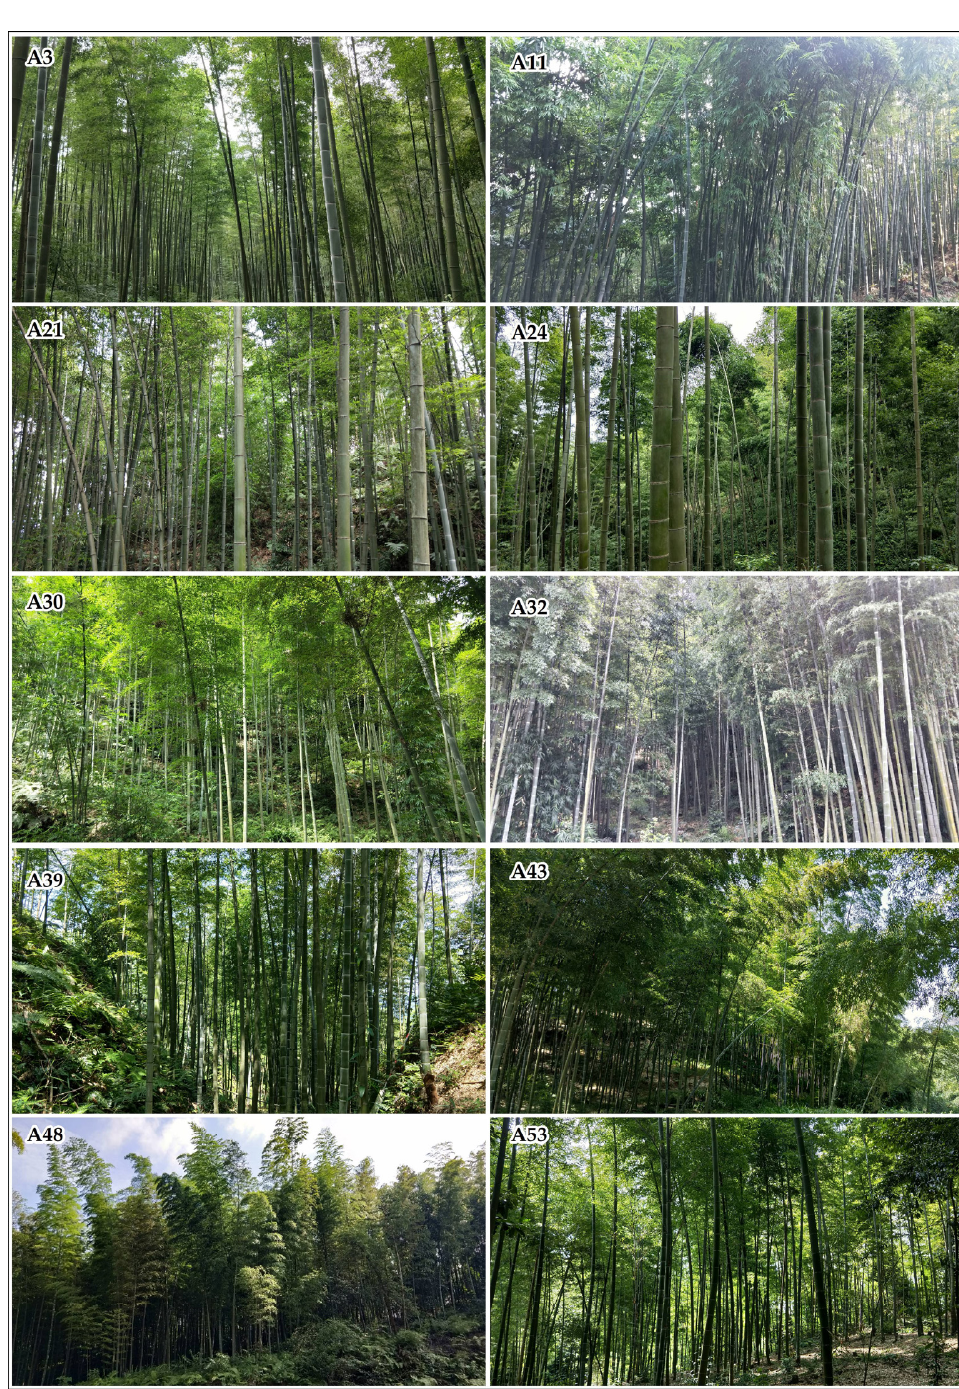
Figure A1. Photos of some Phyllostachys edulis validation points from the field survey.